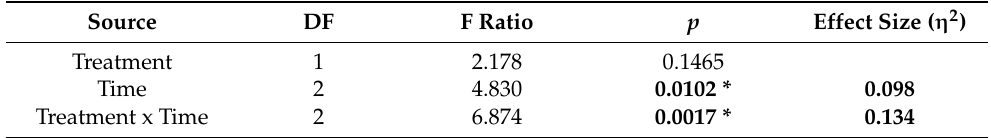
Table 5. Repeated measures ANOVA results for the Intrinsic Motivation Inventory subscale value and